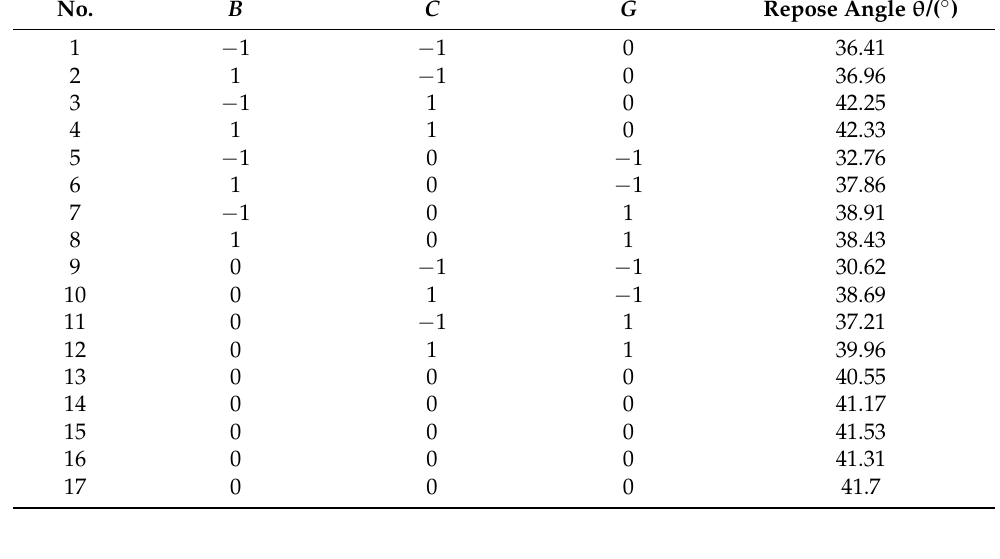
Table 9. Box–Behnken test protocol and results.